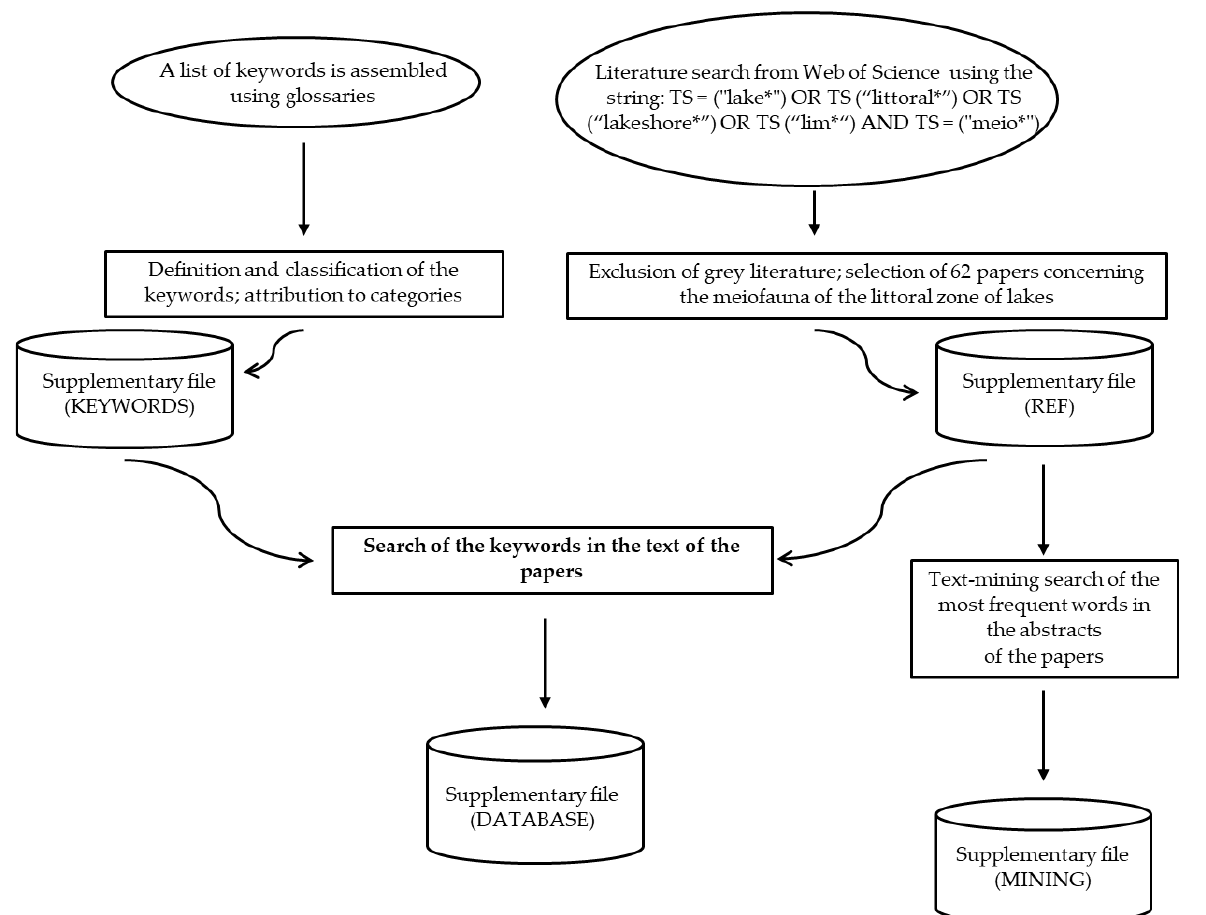
Figure 1. Flow chart of the methodological processes. The ovals indicate the initial phases, the rectangles represent the processes (the main process is in bold) and the cylinders indicate the databases.